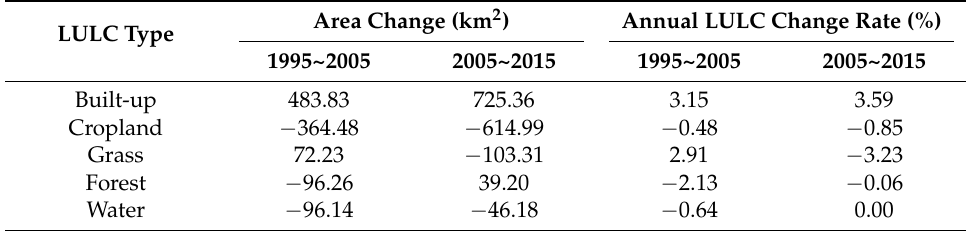
Table 3. The rate of change for